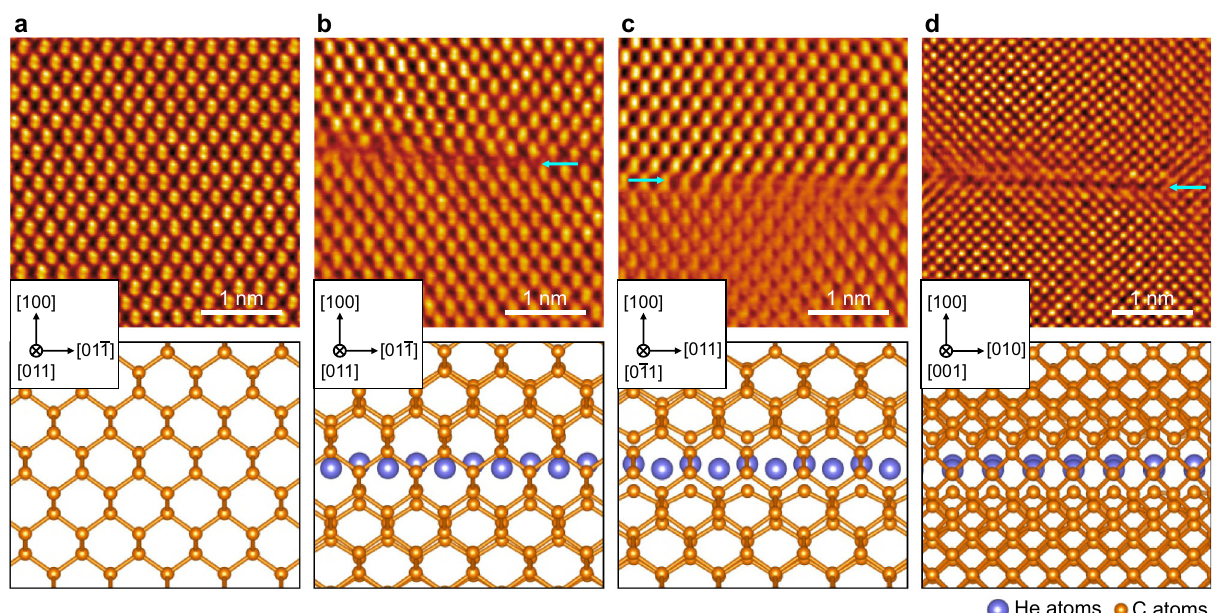
Fig. 3 | Evidence oftwo-dimensional solid helium con fi ned by diamond. a iDPC STEMimages(upper)andthecorrespondingsimulatedatomicstructure(lower)of the pristine diamond viewed along the [011] zone axis. iDPC STEM images (upper) and the corresponding simulated atomic structures (lower) of diamonds